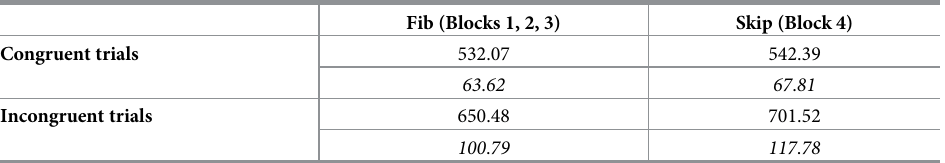
Table 5. Mean ( Standard Deviation ) reaction times for congruent and incongruent trials in Fib and in Skip (Anal- ysis